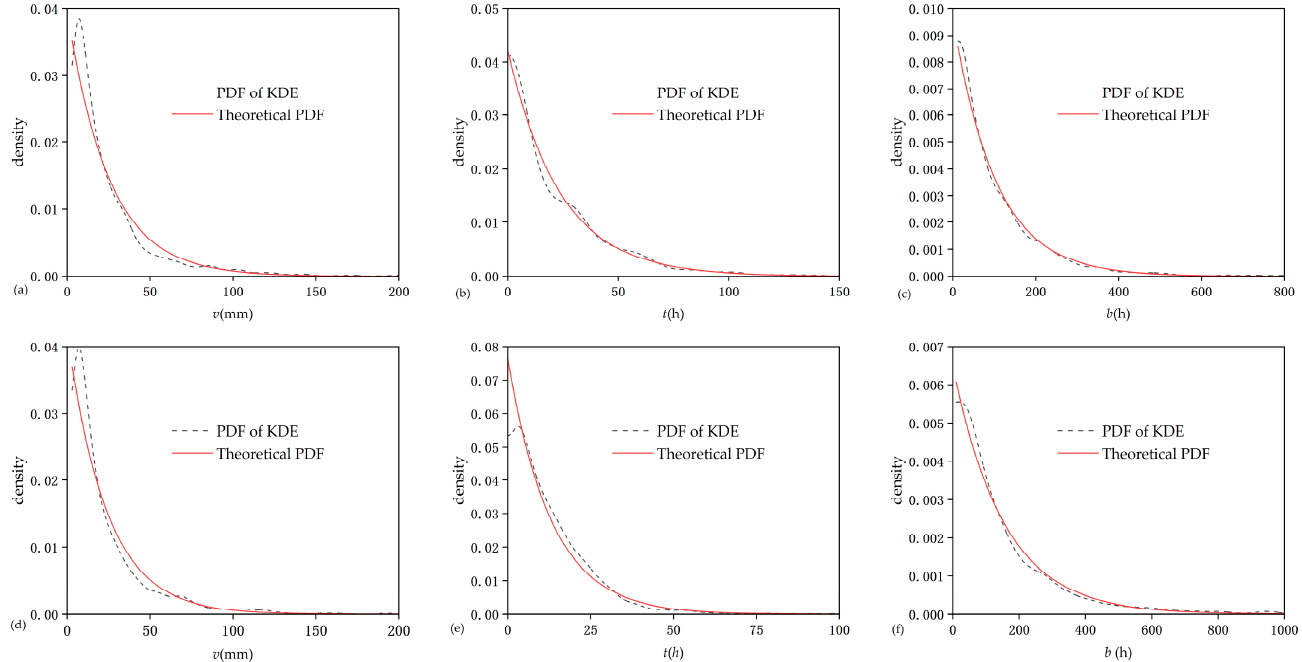
Figure 3. Comparison of the KDE-based PDFs and theoretical exponential PDFs of rainfall event volume v , rainfall event duration t , rainfall inter-event time b : ( a – c ). Hangzhou (MIET = 12 h, v t = 3 mm); ( d – f ). Jinan (MIET = 10 h, v t = 3 mm).